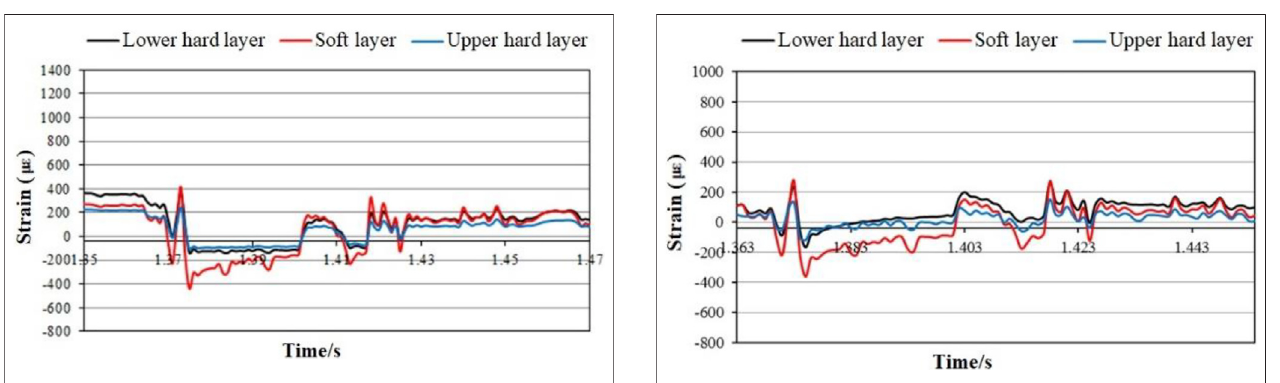
FIGURE 9 | Vertical strain characteristic curve Ⅱ during simultaneous blasting of Nos 1, 2, and 3.